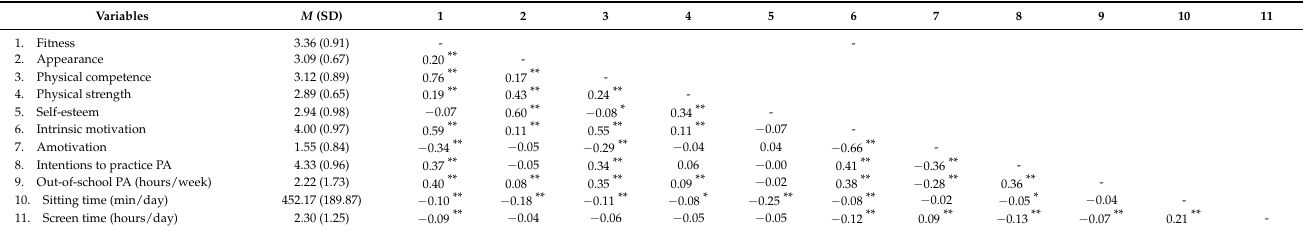
Table 1. Descriptive statistics and bivariate correlations between study variables.